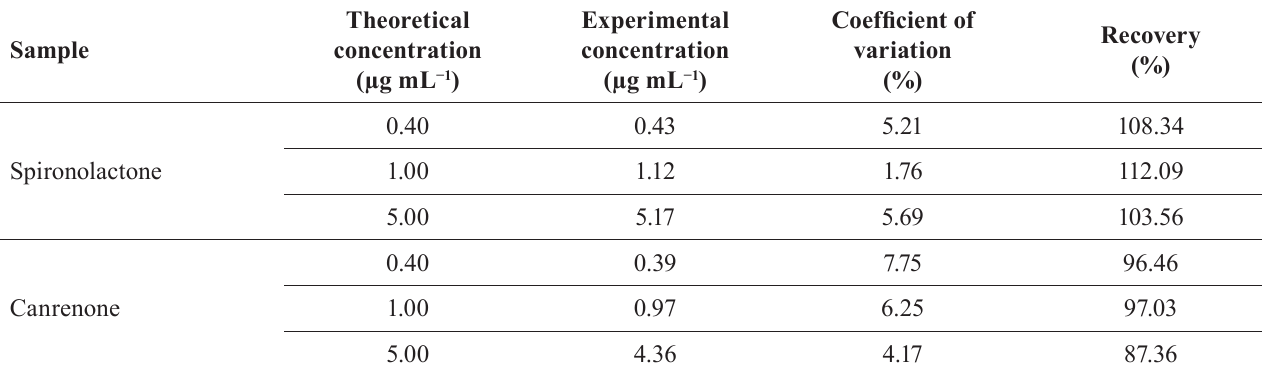
TABLE IV – Accuracy of the analytical method used for quantifying spironolactone and canrenone